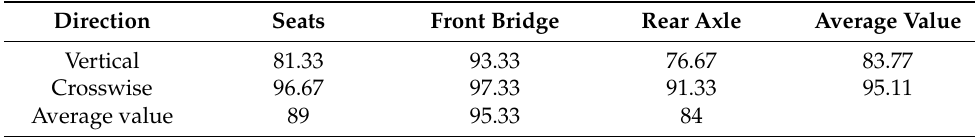
Table 6. Recognition accuracy of random forest (%).